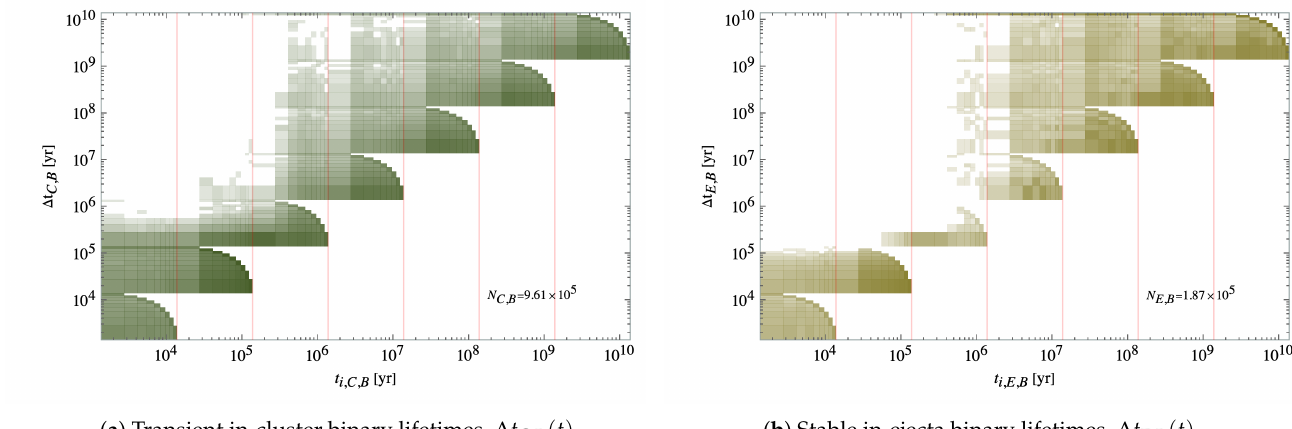
Figure 15. All panels: Binary lifetime histogram for in-cluster and in-ejecta objects, for each time slice in the simulations. The total number of in-cluster binaries amounts to N C,B = 3.85 × 10 5 objects, while the total number of in-ejecta binaries amounts to N E,B = 7.46 × 10 4 objects, throughout all realisations and